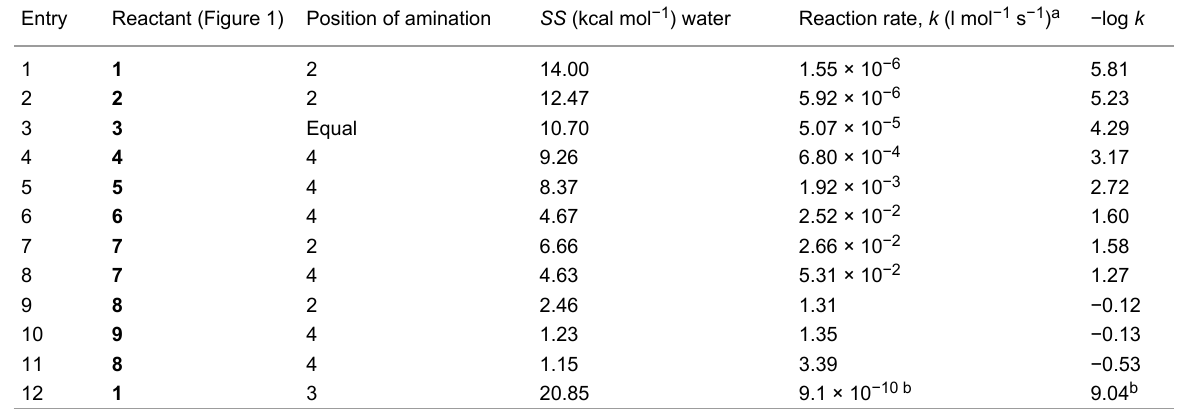
Table 1: Series A. Sigma stability ( SS ), experimental rate constants [28,29] and negative logarithms for experimental rate constants ( − log k ) for the aminations (with NH 3 ) of different reactants in dioxane/water (60:40 v/v) at 25 °C. The structures of the reactants are shown in Figure 1. Entry